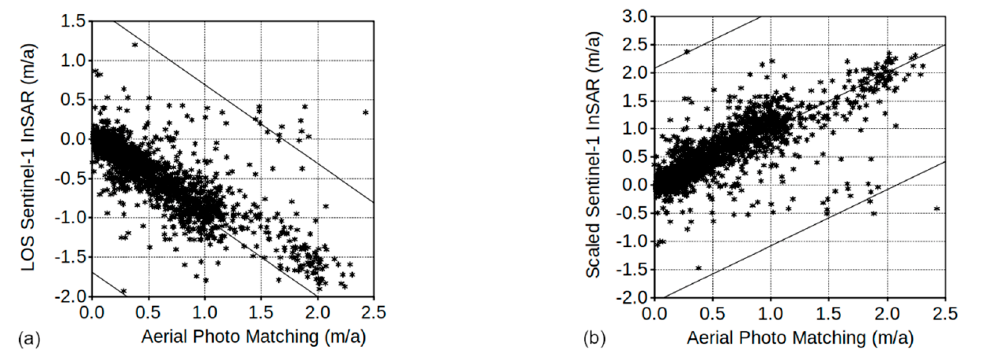
Figure 15. Distelhorn rock glacier (Mattertal, Switzerland). ( a ) Scatter plot of the horizontal velocities from matching of aerial optical images between 03.09.2014 and 21.09.2017 and of Sentinel-1 InSAR line-of-sight velocities from 02.08.2018 to 08.08.2018; ( b ) Scatter plot of the aerial photo matching and scaled (factor − 1.23) Sentinel-1 InSAR velocities. The lines indicate the 1:1 matching and the − 2 π and + 2 π ambiguities.